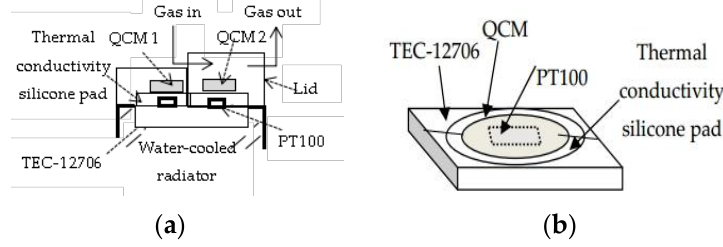
Figure 1. The sensitive structure: ( a ) top view and front view; ( b ) sensor diagram.